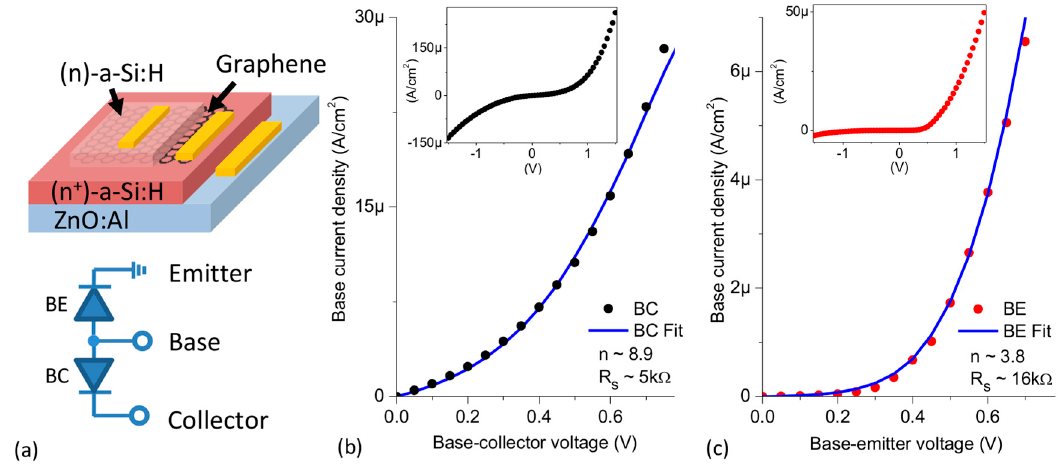
Figure 1. ( a ) Schematic illustration of a graphene monolayer (black) embedded by two (n)-a-Si:H layers (the top layer is the emitter and the bottom layer is the collector). Forward-bias output characteristics of the ( b ) BC (base-collector) and ( c ) BE (base-emitter) interfacial diodes. Insets: Forward and backward bias of the ( b ) BC and ( c ) BE diodes.